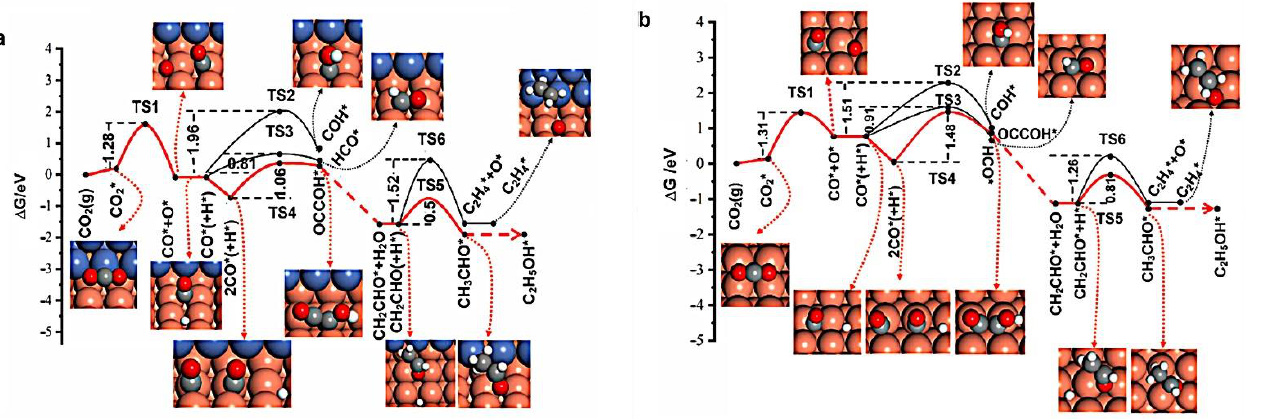
Figure 7. ( a ) Free energy diagram for CO 2 reduction to ethanol and ethylene on the Cu@Ni interface, ( b ) free energy diagram for CO 2 reduction to ethanol and ethylene on Cu (100) surface. The red line represents the lowest energy path. The Cu, Ni, C, O, and H atoms are shown in brown, blue, gray, red, and white, respectively. Reproduced with permission from reference [75].